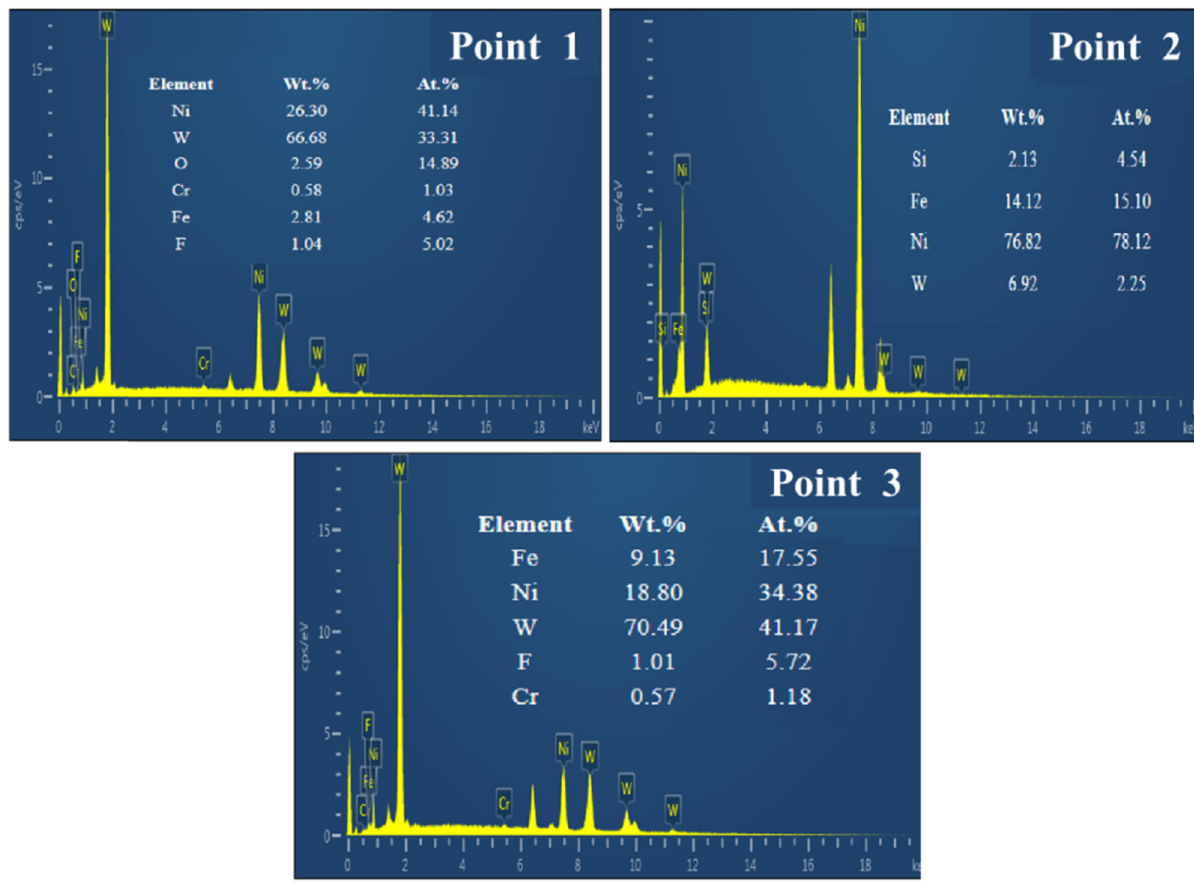
Figure 7: EDS Spectrum of di ff erent points of composite coatings marked in Figure 6.